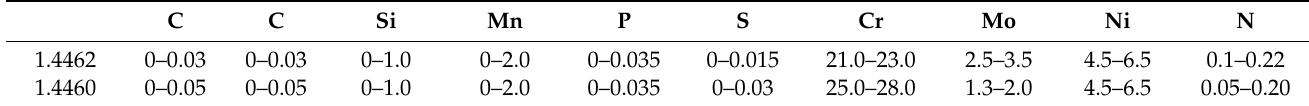
Table 1. Chemical composition of duplex steels X2CrNiMoN22-5-3 (1.4462) [24] and X3CrNiMoN27-5-2 (1.4460) [25].